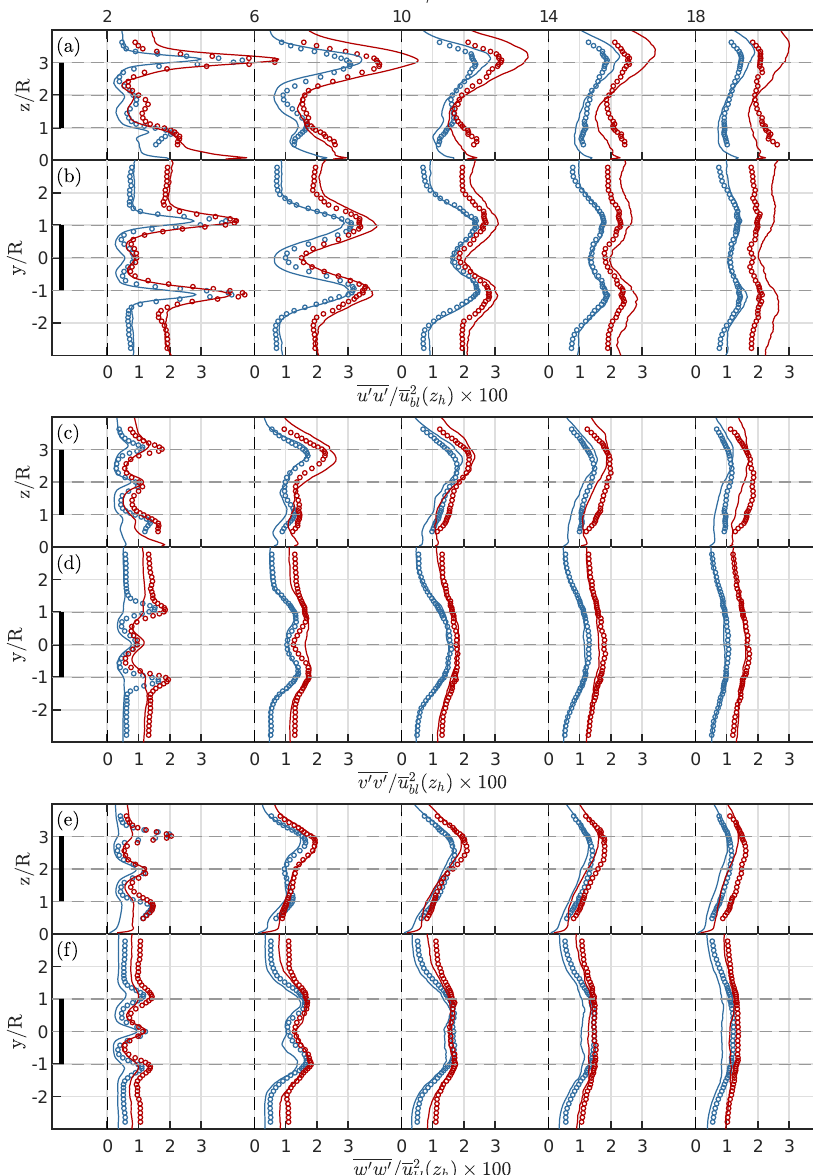
Figure 13. Profiles of the turbulence intensities in axial direction u (cid:48) u (cid:48) (top), in lateral direction v (cid:48) v (cid:48) and in vertical (wall − normal) direction w (cid:48) w (cid:48) (bottom), normalized by u 2 ( b , d , f ) mid − horizontal planes at axial positions x / R = 2, 6, 10, 14, 18. Circles denote measurements, whereas lines correspond to LES results. The color code denotes the shear exponent α = 0.16 (blue) and α = 0.32